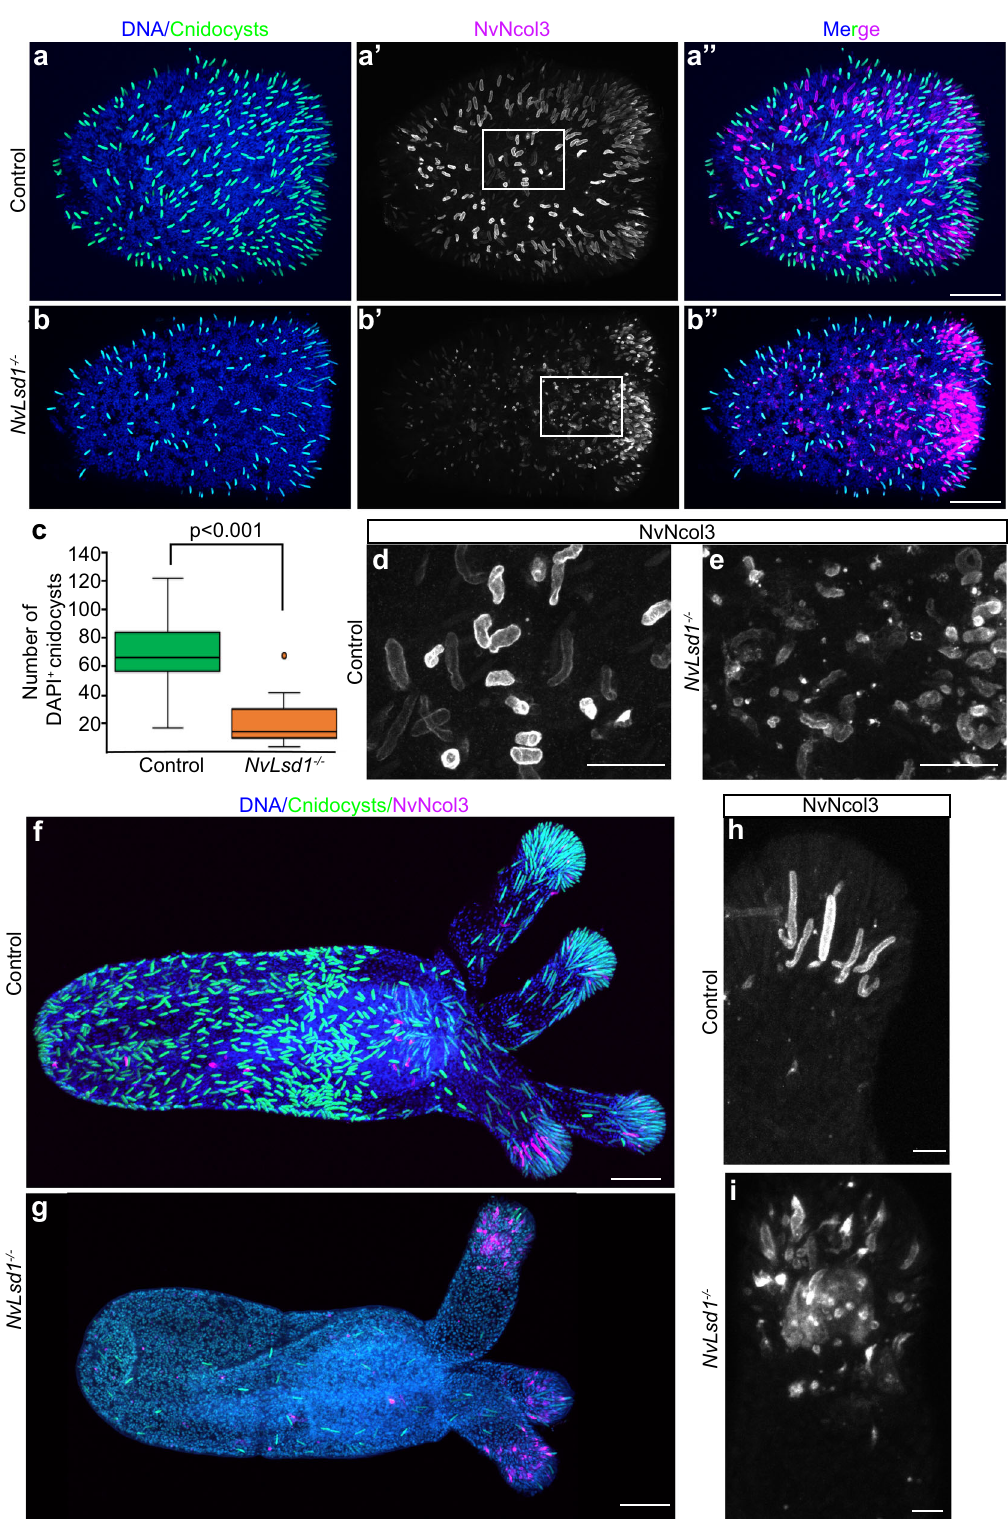
upregulated in NvElav1 ::mOrange + neurons, NvLsd1 levels were shown to also be high in these cells. We therefore analyzed whether loss of NvLsd1 affects the NvElav1 ::mOrange + nervous system. In mutant primary polyps, the expression of the transgenic reporter is less uniform, with many mOrange + punctae, which are not present in controls, and with an apparent expansion of fl uorescence into endodermal epithelial cells (Supplementary Fig. 10a, b). We could